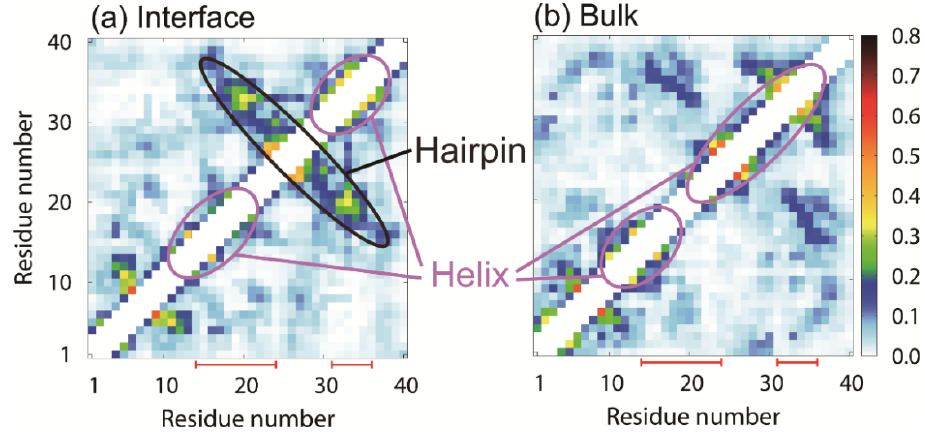
Figure 6. Contact probabilities of C α atoms ( a ) in the presence of the interface and ( b ) in the absence of the interface. Red solid lines correspond to the residues with helix structures in the experiments with the lyso-GM1 [93]. Reprinted with permission from Reference [25]. Copyright 2019 American Chemical Society.